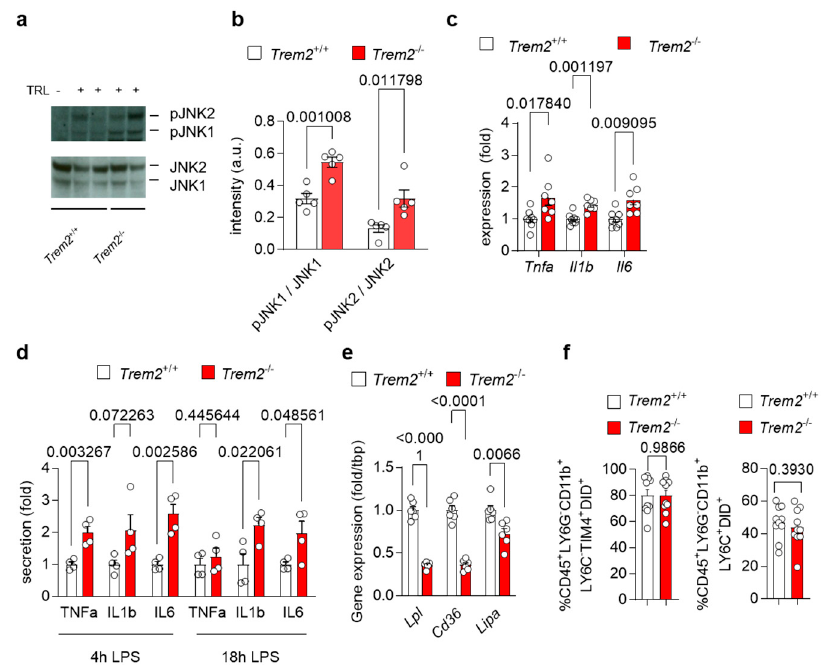
Figure 2. Trem2 controls LPS- and TRL-induced hepatic pro-inflammatory response ( a – c ) WT ( Trem2 +/+ ) and Trem2 − / − mice were injected with TRL particles. ( a ) Western blot of JNK1 and JNK2 as well as phosphorylated JNK1 and JNK2 and ( b ) its quantification ( n = 4). ( c ) Hepatic gene expression of Tnfa , Il1b and Il6 ( n = 7). ( d ) KC from WT ( Trem2 +/+ ) and Trem2 − / − mice were treated with LPS and secretion of TNF α , IL1 β and IL6 into the media was measured after 4 and 18 h ( n = 4). ( e ) Gene expression of Lpl , Cd36 and Lipa in WT ( Trem2 +/+ ) and Trem2 − / − BMDMs. ( f ) Uptake of DiD-labeled TRL particles into WT ( Trem2 +/+ ) and Trem2 − / − macrophages ( n = 9–10). Data are shown as mean + SEM. Statistically significant differences between groups ( p < 0.05) were determined by Student`s t- test ( a – e ) or Mann–Whitney test ( f ) and are indicated as p -value.